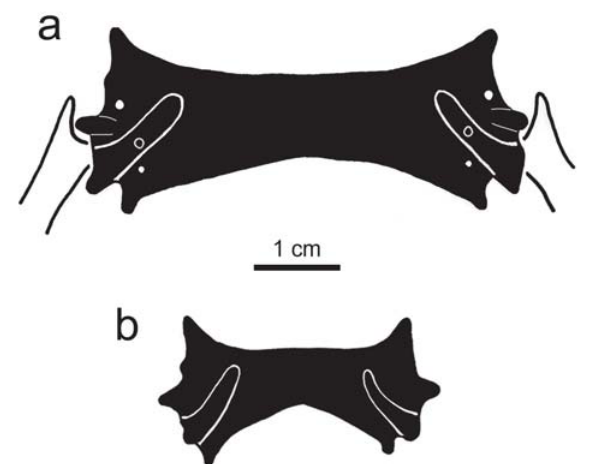
Fig. 12. Left scapulocoracoid of Malacoraja obscura , n. sp. (MNRJ 28292, 295 mm TL) in lateral view (specimen is male).